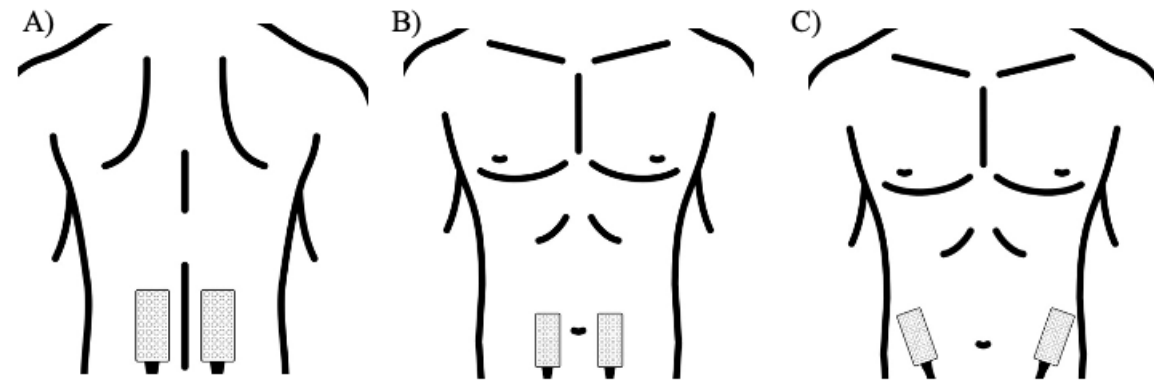
Figure 1. Illustrated HDEMG grid placement of the ( A ) erector spinae, ( B ) rectus abdominis ( C ) external obliques.